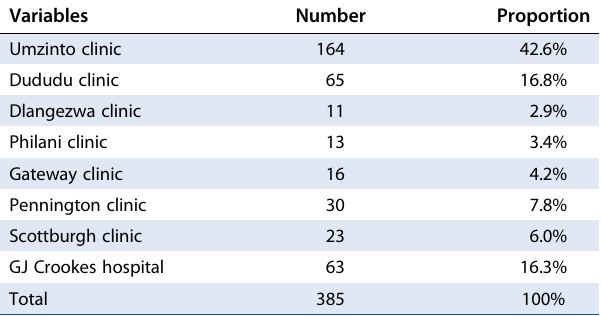
Table 2: Frequency of the sociodemographic profile between Implanon users and non-users at a district hospital and PHC clinics in Ugu